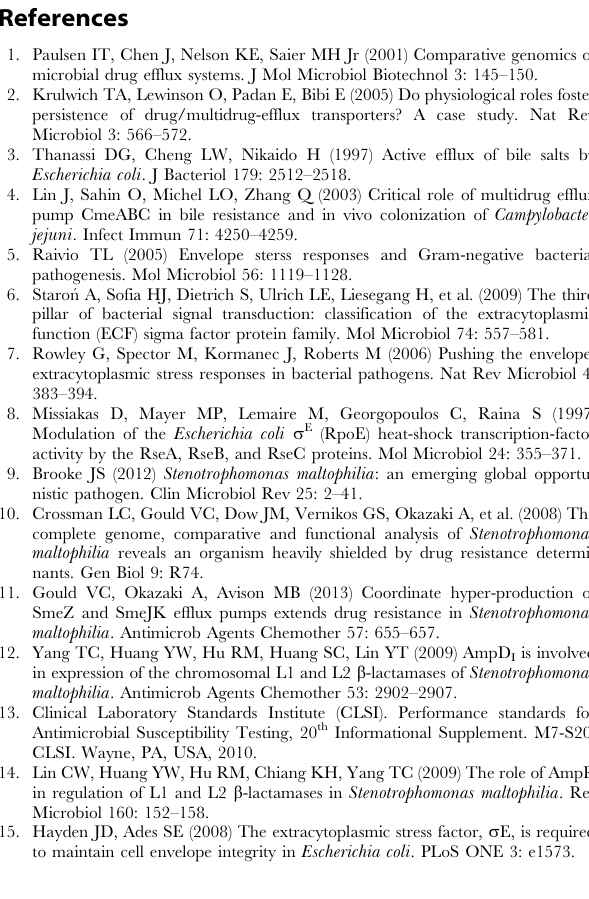
Figure S3 The DNA sequences upstream of the smeIJK operon. The orientation of gene is indicated by the arrow. The putative 2 35/ 2 10 regions of the rpoE promoter are boxed, based on the reported consensus sequence for the s E -regulated promoter elements of X. campestris pv.campestris. Table S1 Bacterial strains, plasmids and primers used in this study. Table S2 The homologues of SmeIJK efflux